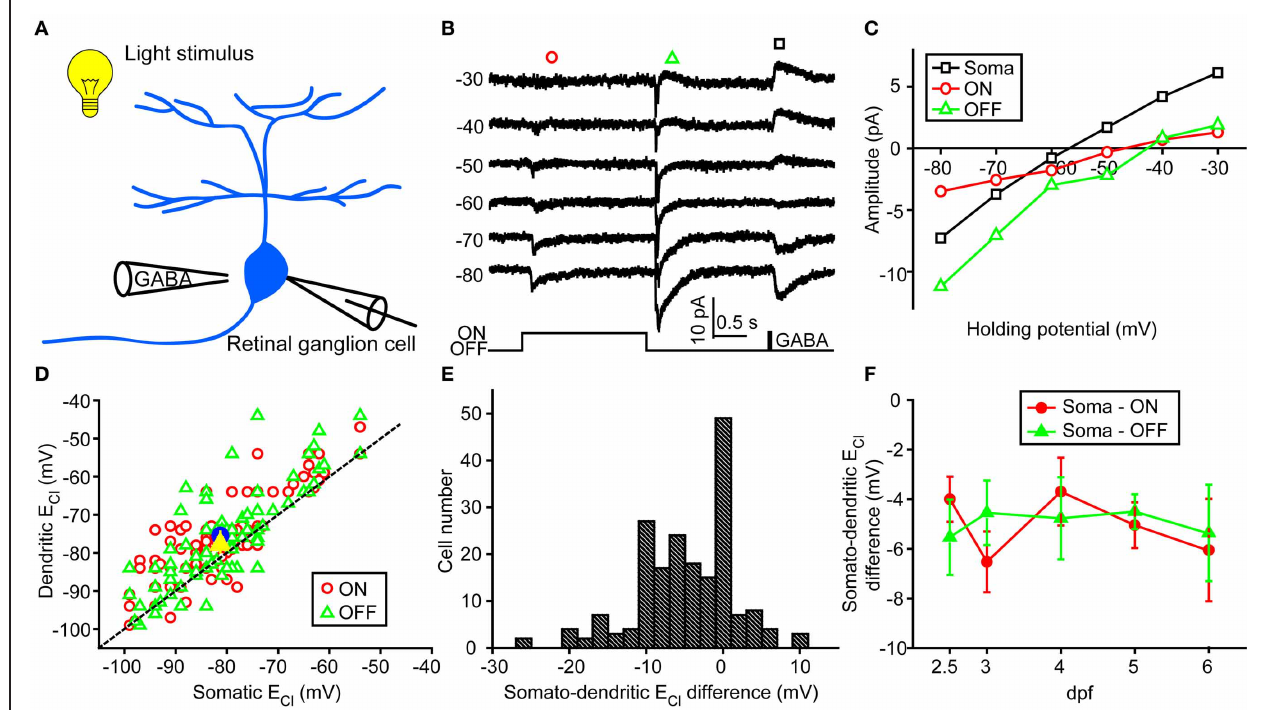
FIGURE 2 | Somato-dendritic E Cl difference of zebrafish ON-OFF RGCs. (A) A schematic showing the experimental procedure. (B) Light-evoked ON (red circle) and OFF (green triangle) synaptic responses and GABA-induced currents (black square) were simultaneously recorded at different holding potentials from an ON-OFF RGC under gramicidin-perforated patch recording mode. (C) I–V curves of GABA-induced current at the RGC soma (black square), and the late-phase components of ON (red circle) and OFF (green triangle) light-evoked responses. The data were obtained from the